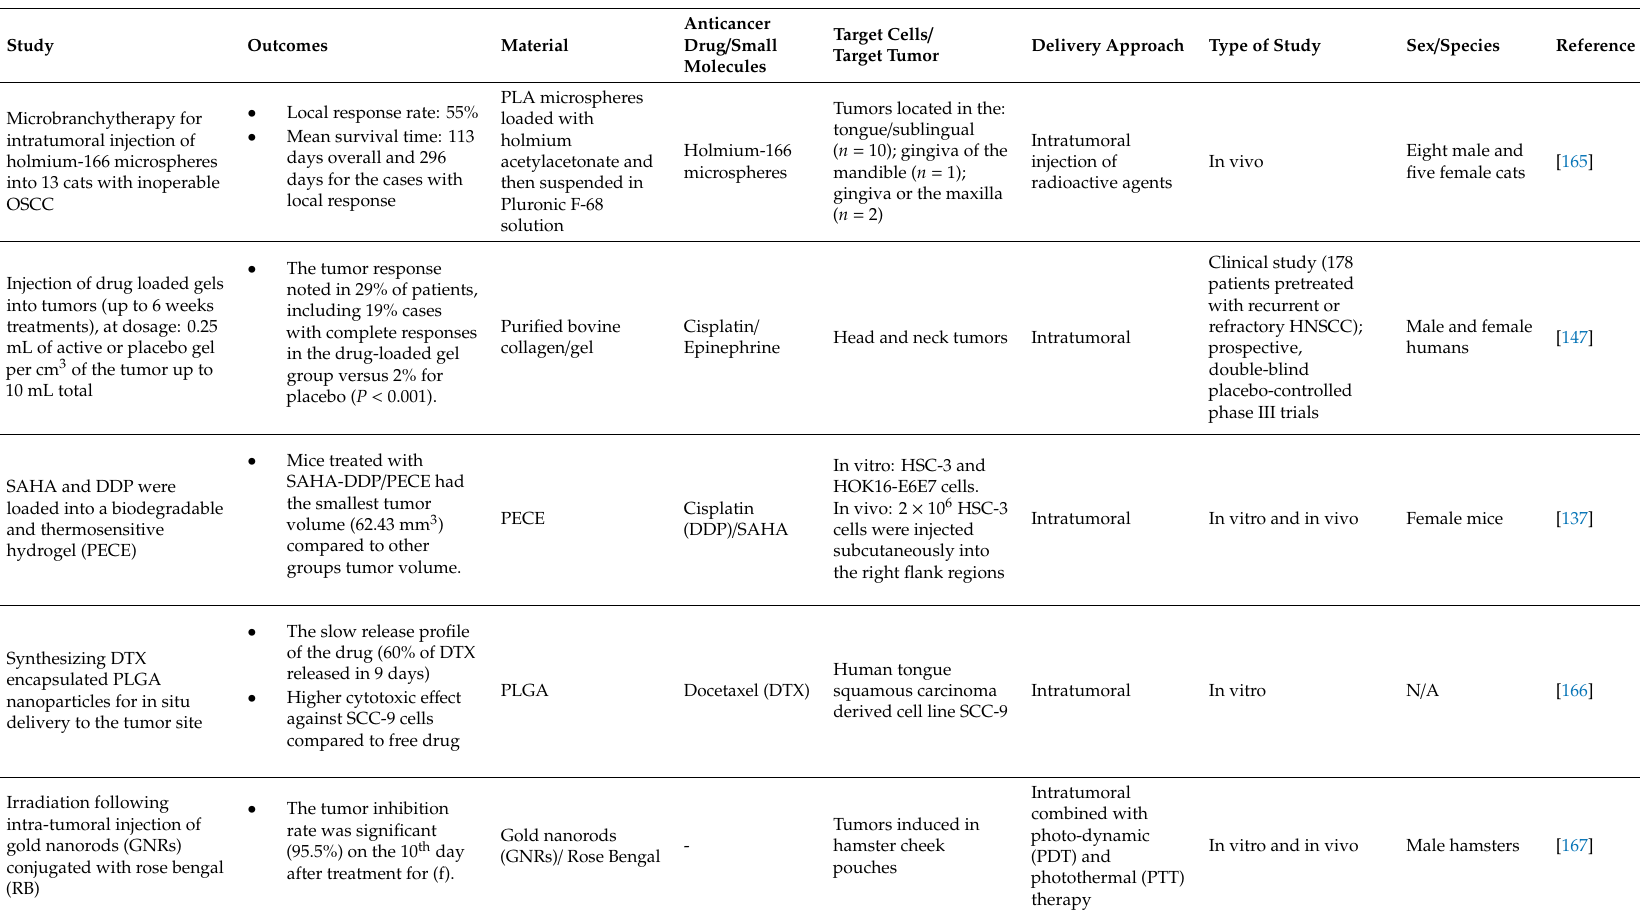
Table 2. Drug delivery studies for the treatment of oral cancer. OSCC: oral squamous cell carcinoma; PLA: poly(lactic acid); SAHA: suberoylanilide hydroxamic acid; DDP: cisplatin; EGFR: epithelial growth factor